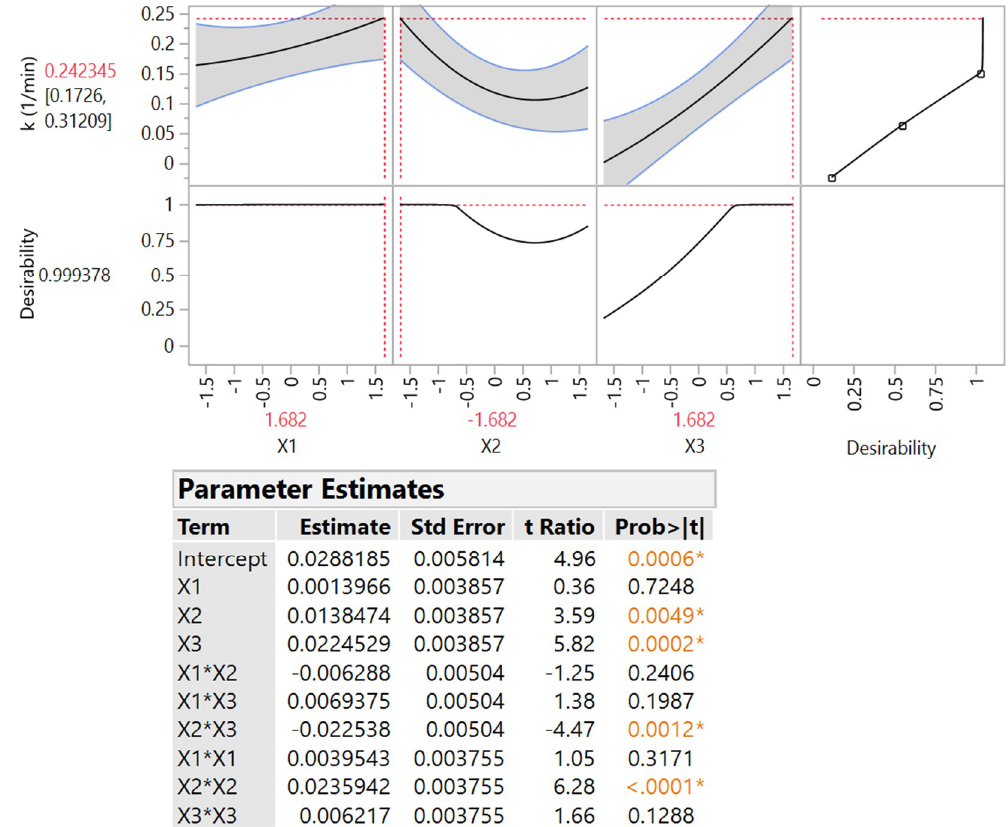
Figure 5. Desirability function and parameter estimates (inset table) determined after implementing a central composite design—uniform precision methodology. Asterisk (*) denotes statistically significant terms.